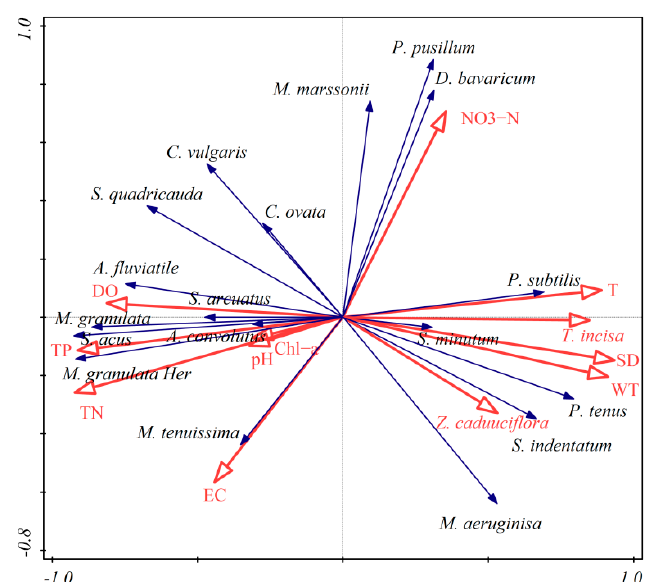
Figure 5. A sequencing map of the RDA phytoplankton species (blue lines with arrowhead) and the environmental parameters (red lines with arrowhead).